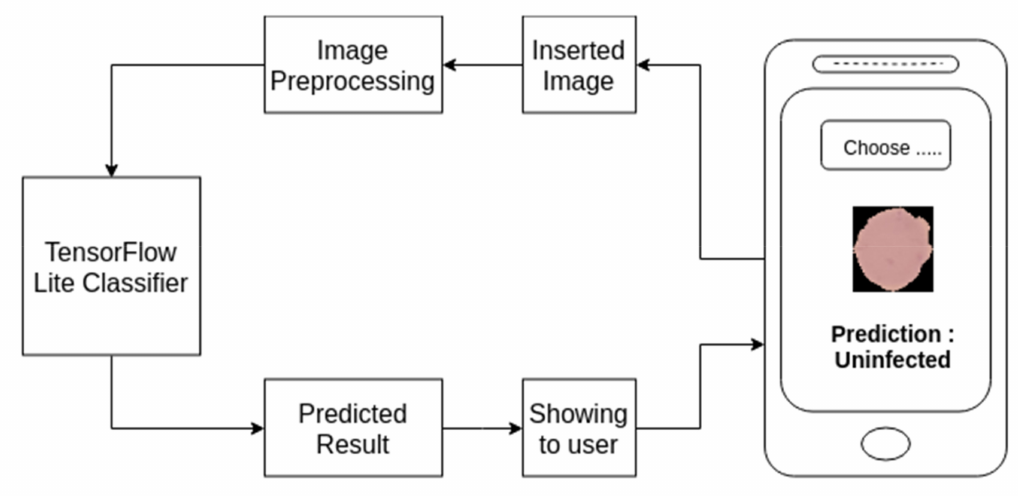
Figure 14. Outline of mobile based service.